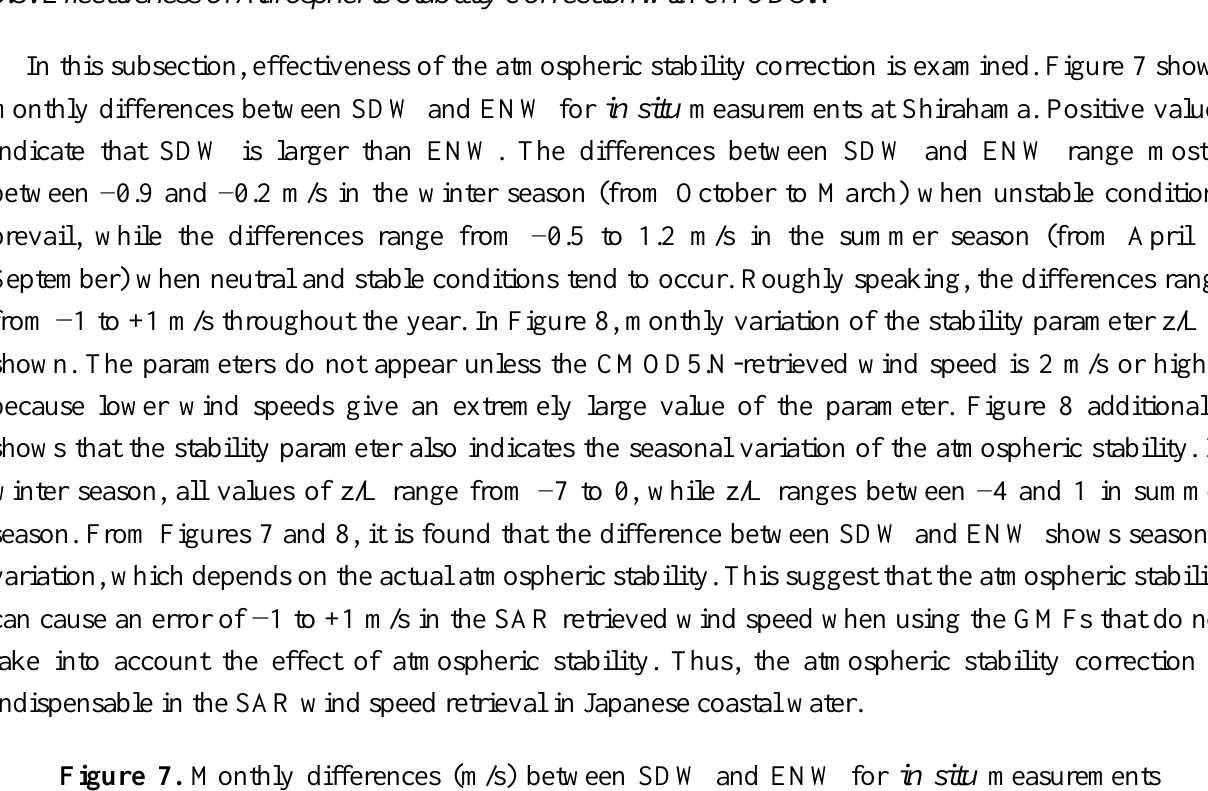
Figure 7. Monthly differences (m/s) between SDW and ENW for in situ measurements at